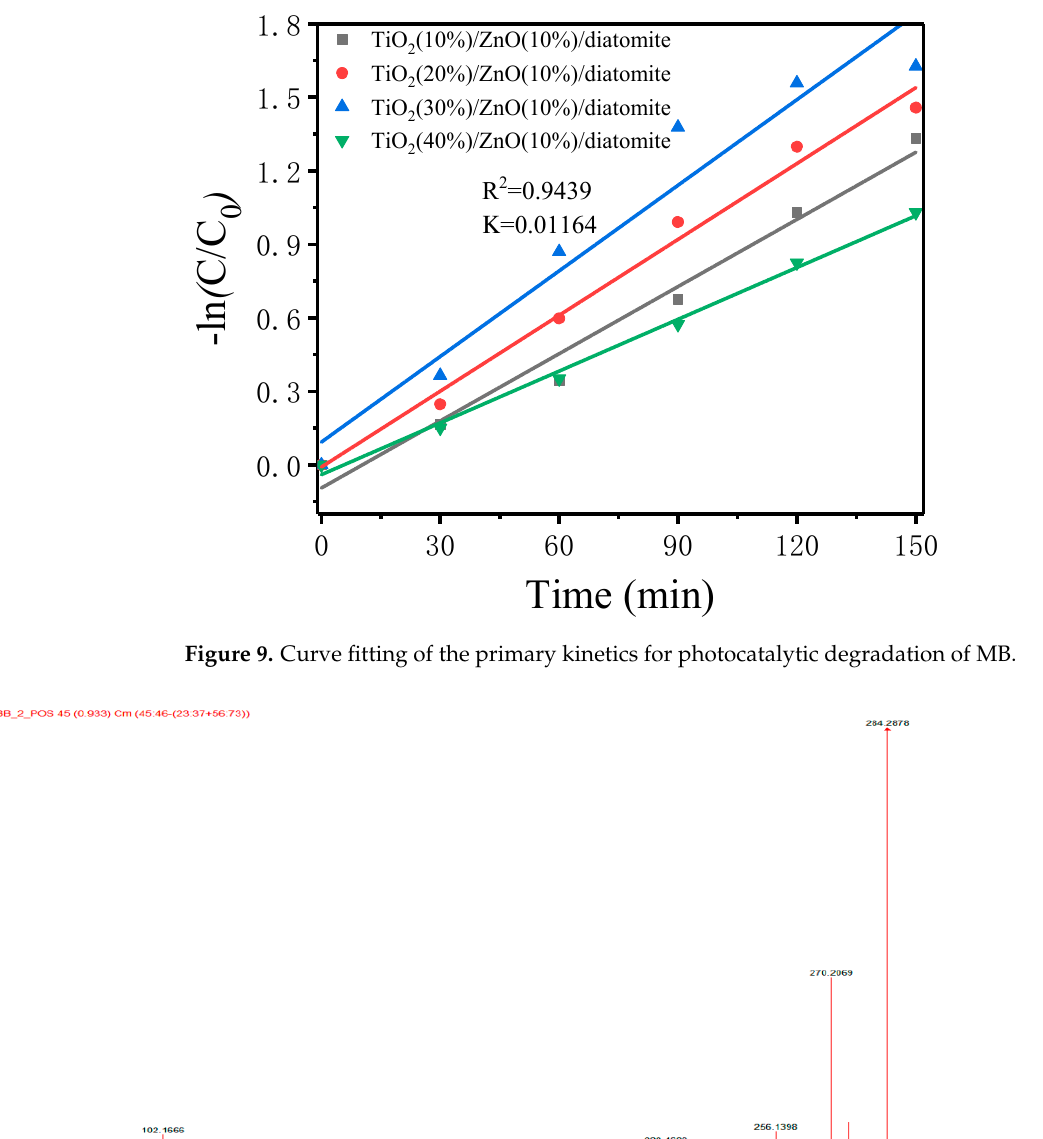
Figure 8. MB photodegradation of various catalysts under visible light.